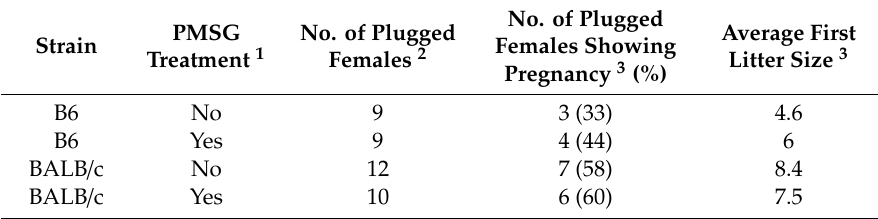
Table 2. Summary of litter size and the rates of females showing successful pregnancy after low-dose PMSG